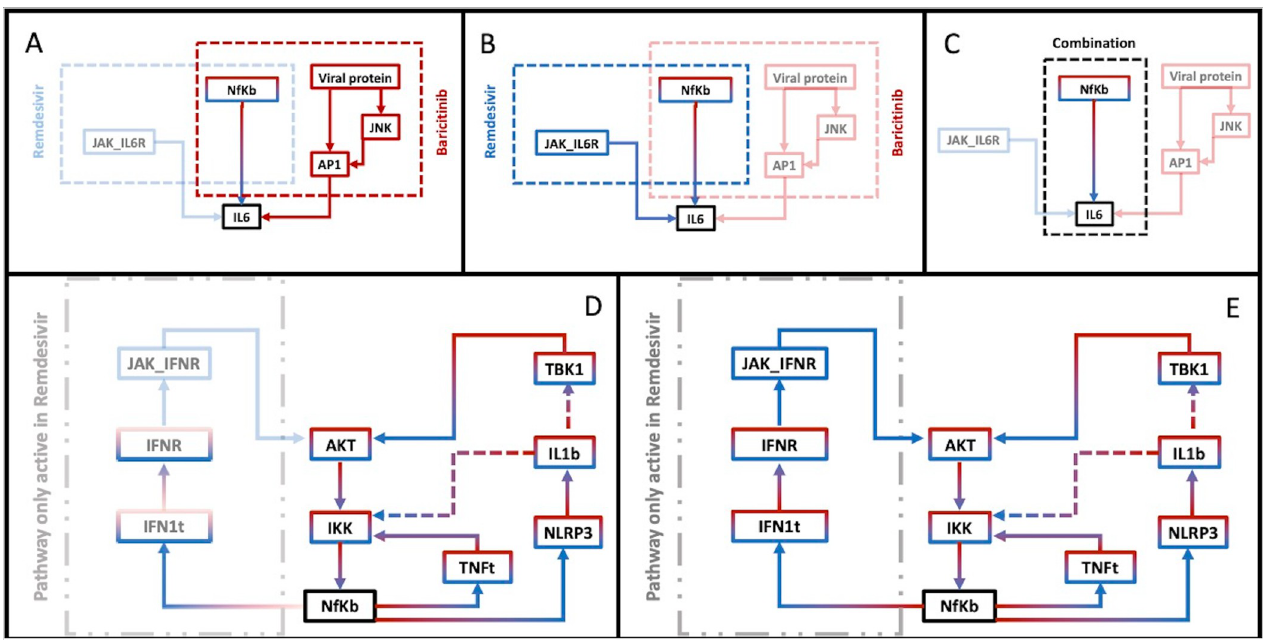
Fig 5. IL6 recruitment and NfKb activation. (A-C) The main regulatory pathways of IL6 obtained by reducing the regulatory network and propagating the fix values. Nodes and arrows are colored corresponding to the treatment studied. (A) IL6 is regulated in Baricitinib by NfKb and AP1 (red lines); (B) Remdesivir acts on IL6 through JAK_IL6R and NfKb (blue lines); (C) The combination therapy maintains only the IL6 regulation via NfKb (red-blue lines). (D-E) Regulatory pathways of NfKb for Remdesivir (blue), Baricitinib (red) and their combination (red-blue). (D) All pathways are activated for Remdesivir. JAK_IFNR is a specific node on a linear regulatory loop on NfKb, present only in Remdesivir. (E) For Baricinib and its combination with Remdesivir, the regulatory loops are reduced to three: a loop through TNF, and two loops via the Inflammasome and IL1b.